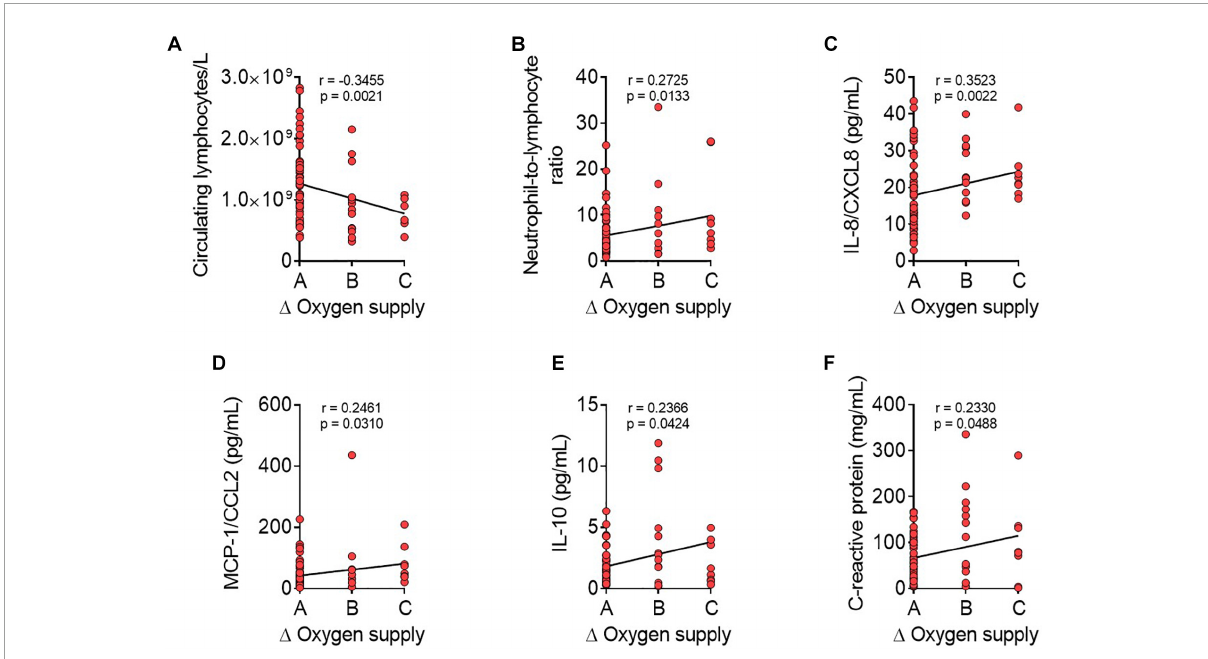
FIGURE3 Coronavirus disease 2019 worsening during hospitalization is correlates negatively with admission lymphocyte counts but positively with admission neutrophil-to-lymphocyte ratio, IL-8/CXCL8, MCP-1/CCL2, IL-10, and C-reactive protein plasma levels. Correlations between admission hemogram parameters [number of circulating lymphocytes/L, (A) and neutrophil-to-lymphocyte ratio, (B) ] or plasma levels of inflammatory mediators [IL-8/CXCL8, (C) MCP-1/CCL2, (D) IL-10, (E) , and C-reactive protein, (F) ] and disease progression ( (cid:49) oxygen supply) were calculated using Pearson/Spearman correlation analysis procedures. Disease progression was calculated for each participant by: maximum oxygen therapy during the hospital stay–oxygen therapy at hospital-admission blood extraction ( (cid:49) oxygen supply). Group A = no changes in oxygen supply; group B = moderate variation in oxygen supply; group C = marked variation in oxygen supply. Values are expressed as individual data points ( n = 78 patients). Data were considered statistically significant at p <